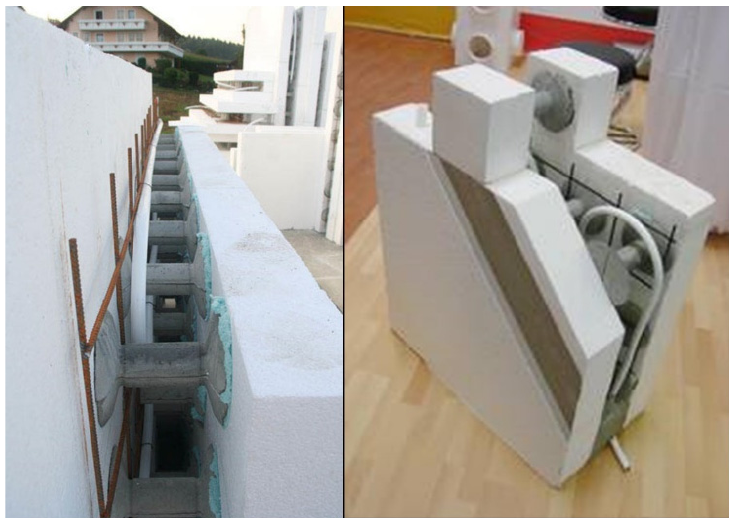
Figure 3. View of the lost formwork of the ISOMAX panel and the principal location of the thermal barrier [2].